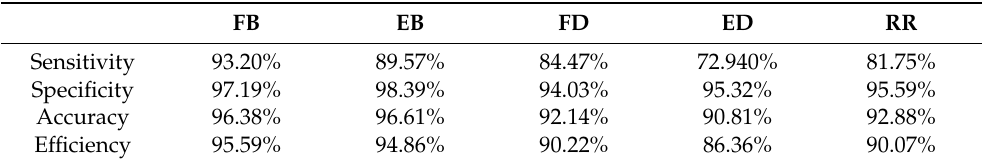
Figure 14. Graph of the classification percentage as a function of the number of iterations using the Gaussian kernel for ( a ) repetition 2 and ( b ) repetition 3. Table 12. Classifier performance parameters for the training stage.